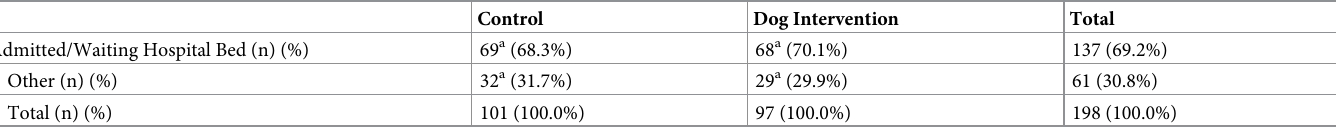
Table 3. Admitted/waiting hospital bed by